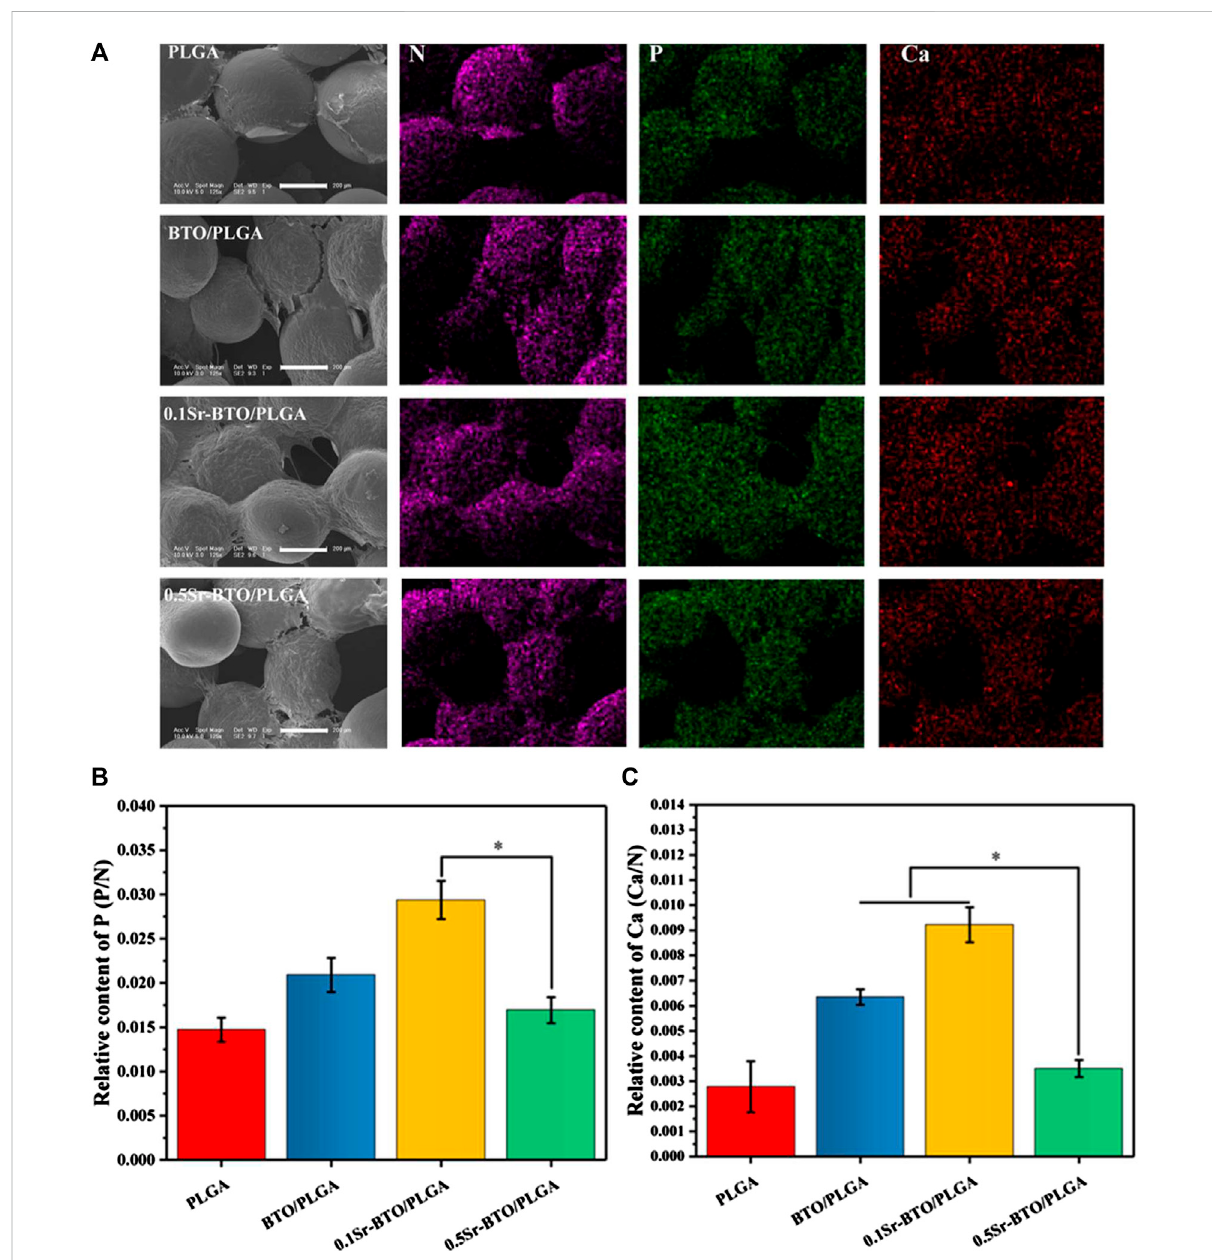
FIGURE 6 (A) The SEM and mapping image of MC3T3-E1 cells cultured on composite microspheres for 14 days. Scale bar: 200 μ m (B,C) The relative contents of phosphorus (P) and calcium (Ca) in the extracellular matrix on different microsphere groups were calculated by N normalization, *p <